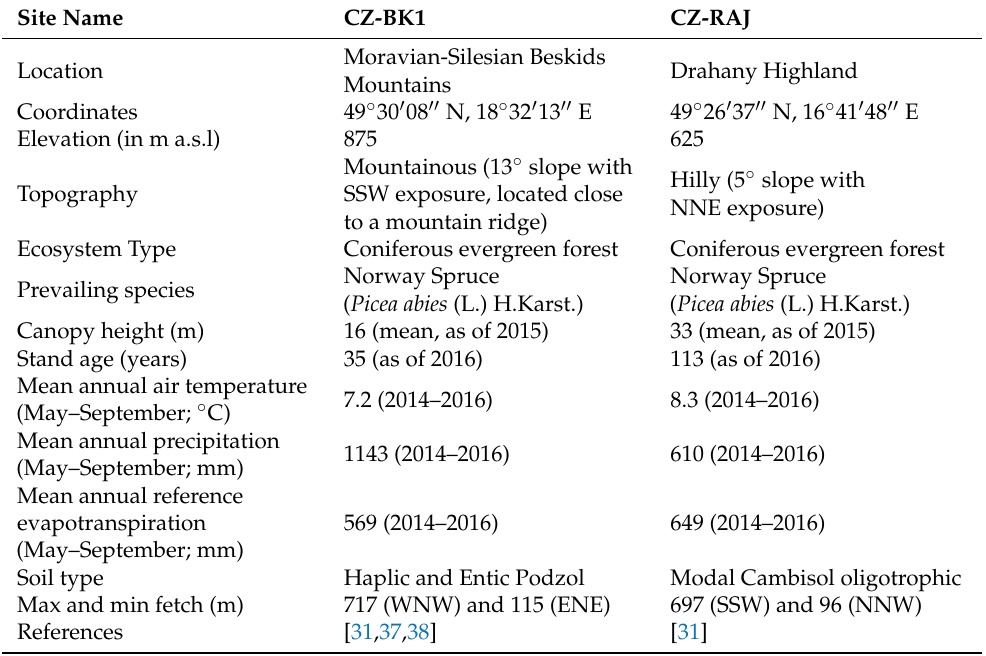
Table 1. Characteristics of the study